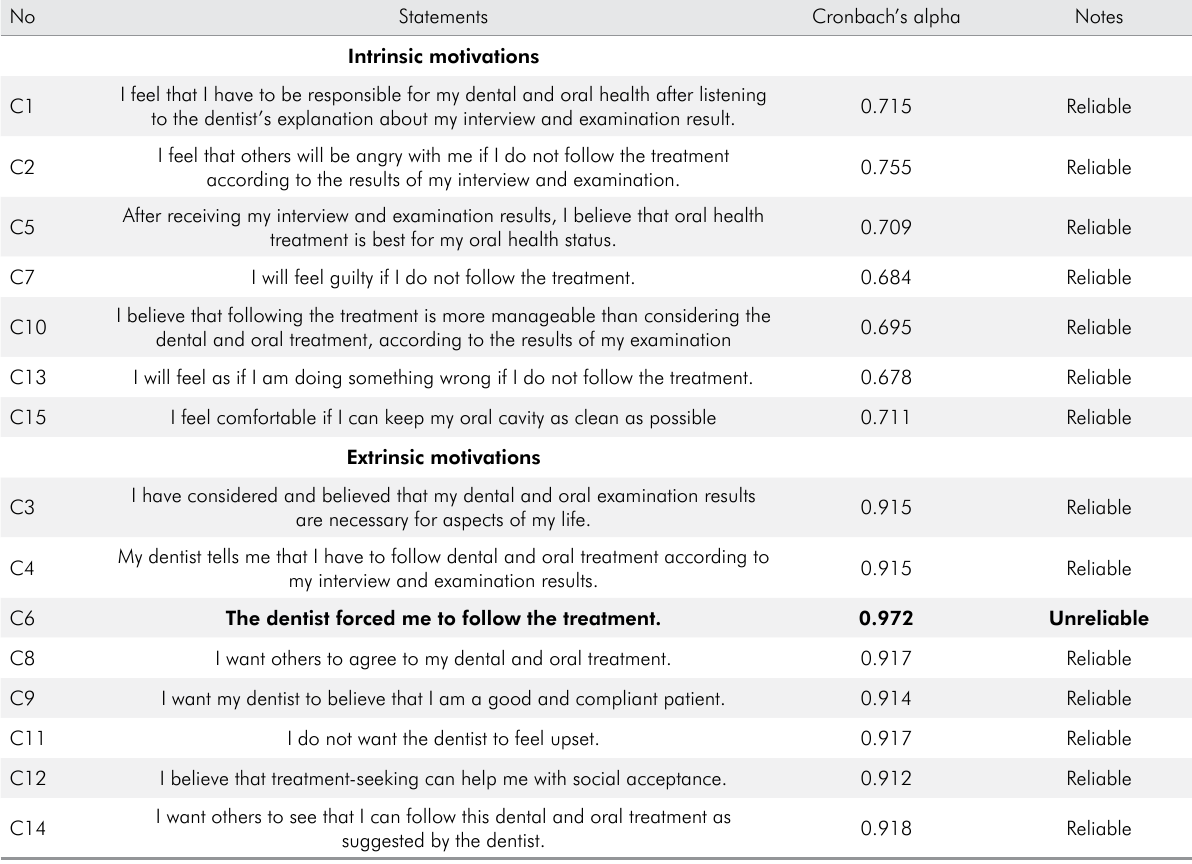
Table 7. Internal consistency reliability of the modified DTMS (n=34)